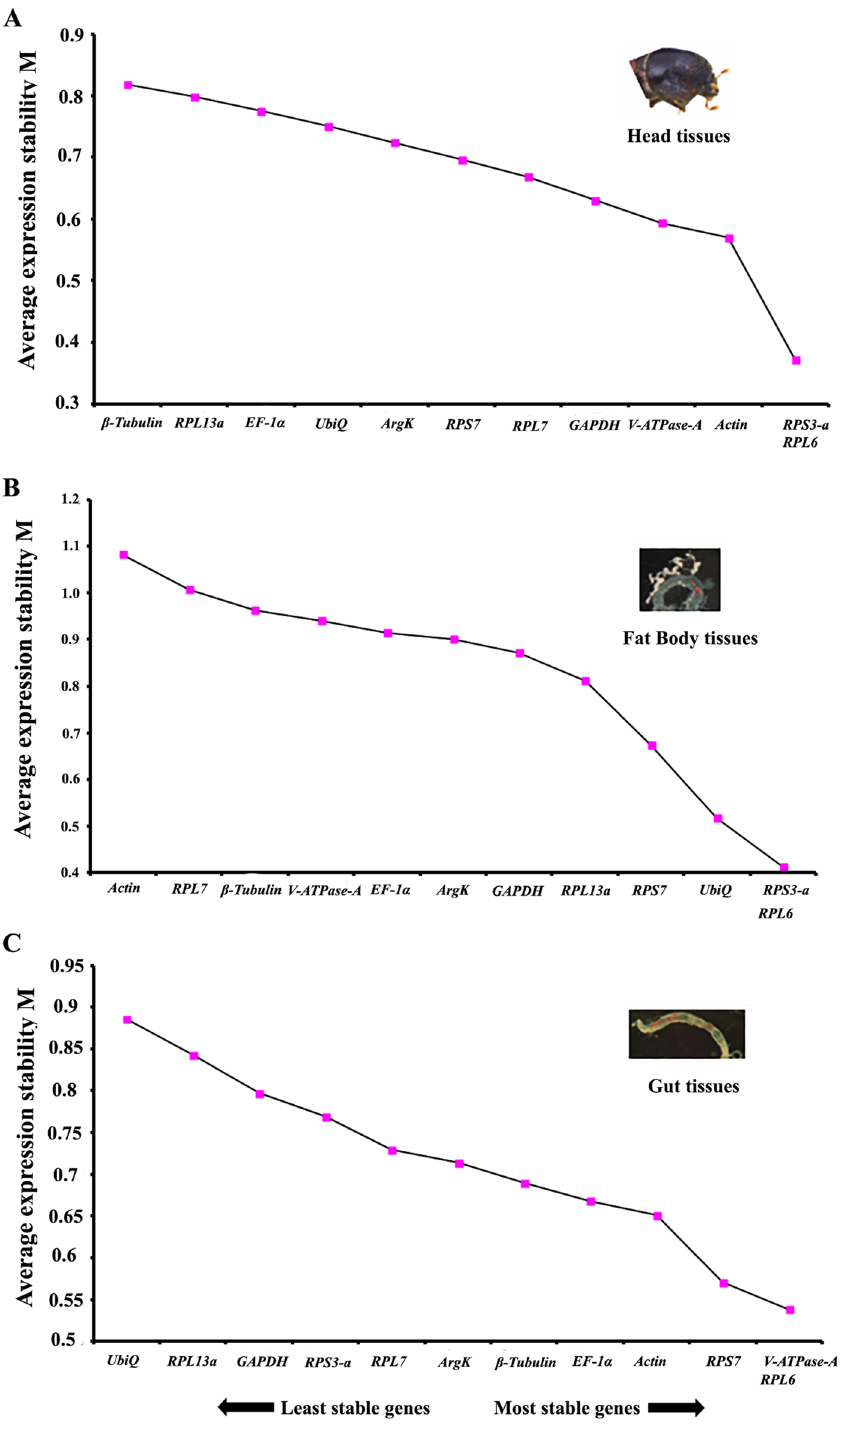
Figure 4. The average expression stability values (M) of twelve reference genes under different tissues calculated by geNorm demonstrating the least stable (left) to the most stable (right). ( A ) head, ( B ) fat body, ( C )